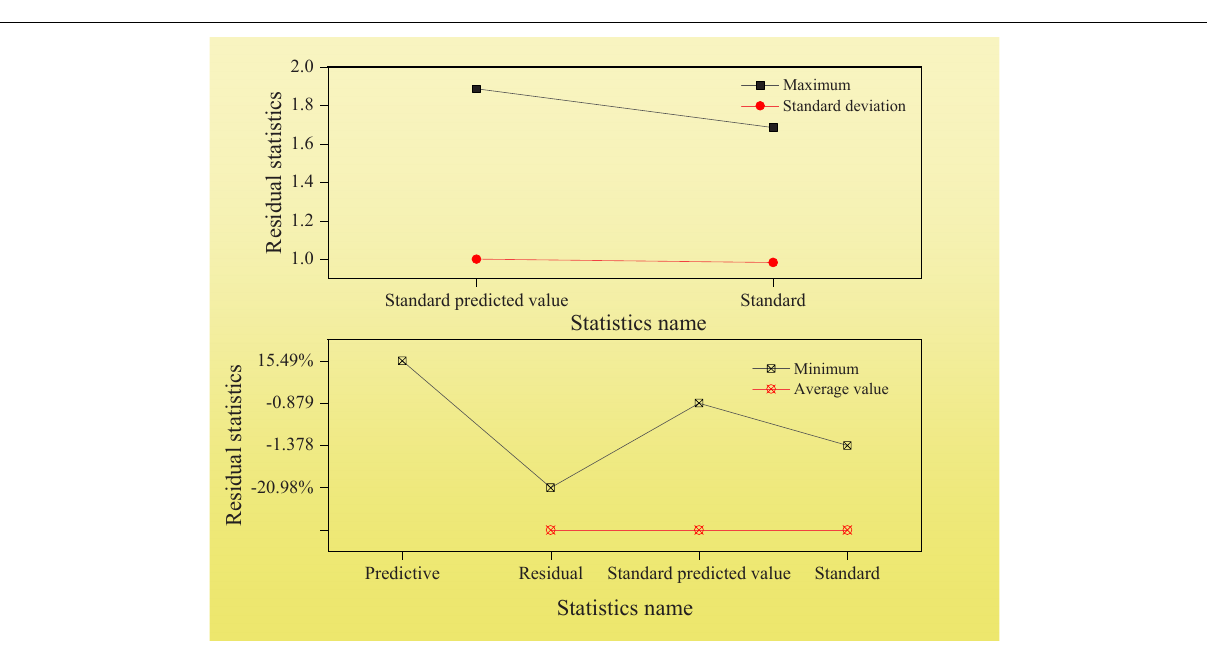
FIGURE 8 | Residual statistical indexes of the linear regression test between the content of likes and CSR score growth